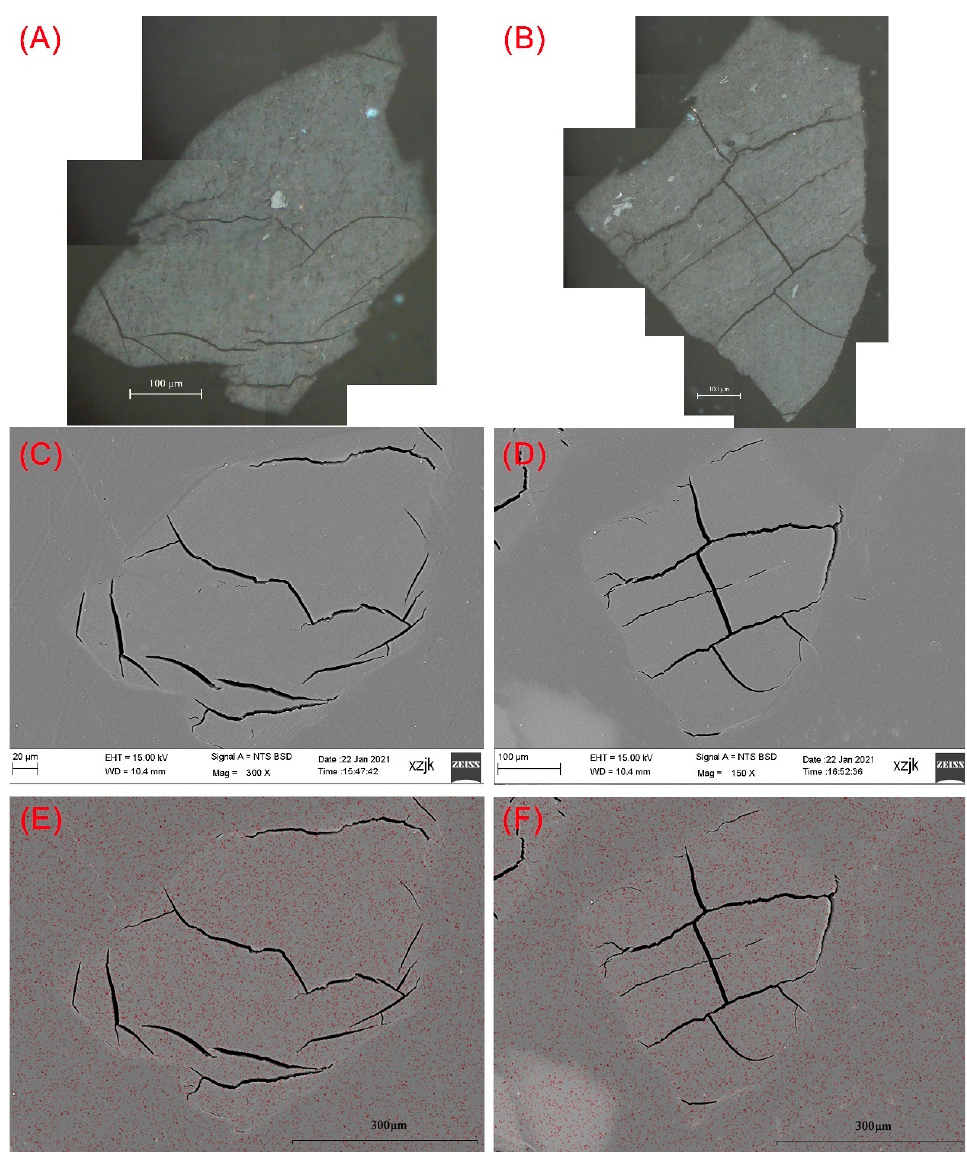
Figure 8. Microscope and SEM–EDS identification of YHV: ( A , B ) collodetrinite (cd) particles; ( C , D ) SEM images of ( A , B ); ( E , F ) Na EDS mappings of ( A , B ).